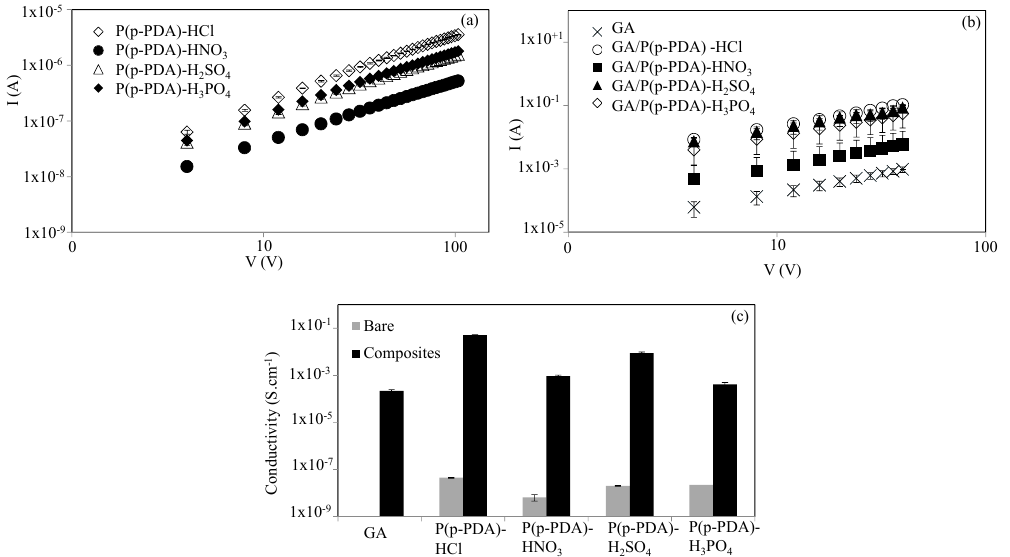
Figure 5. The current (I) versus voltage (V) plots of ( a ) p(p-PDA) polymers, ( b ) GA/p(p-PDA) composites and ( c ) comparison of calculated conductivity values for p(p-PDA) and GA/p(p-PDA) composites.